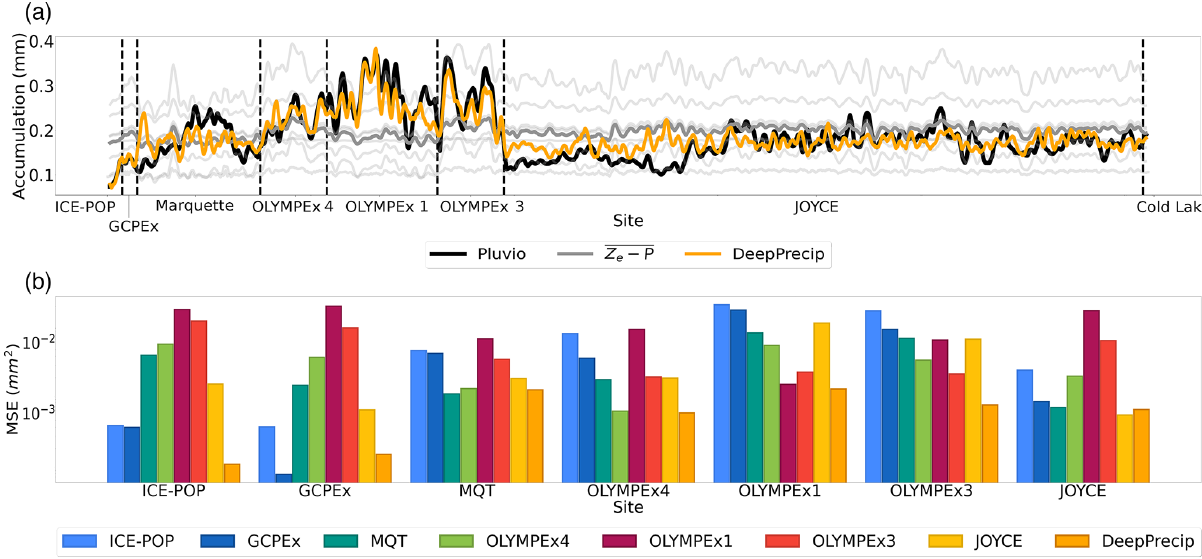
Figure 5. Site-derived empirical Z e − P power law performance comparisons. (a) The same as Fig. 4a, except now using Z e − P relationships derived at each study site. (b) MSE values for DeepPrecip and each Z e − P relationship when tested on each site.